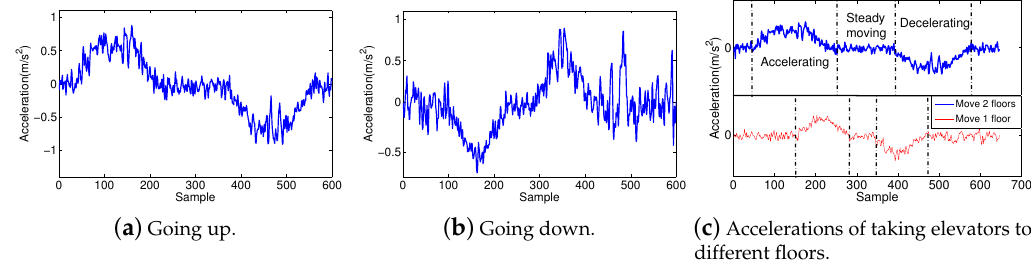
Figure 8. Accelerations of taking